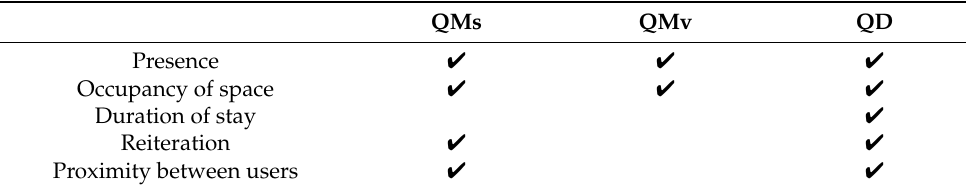
Table 2. Assessment of the different criteria by the 3